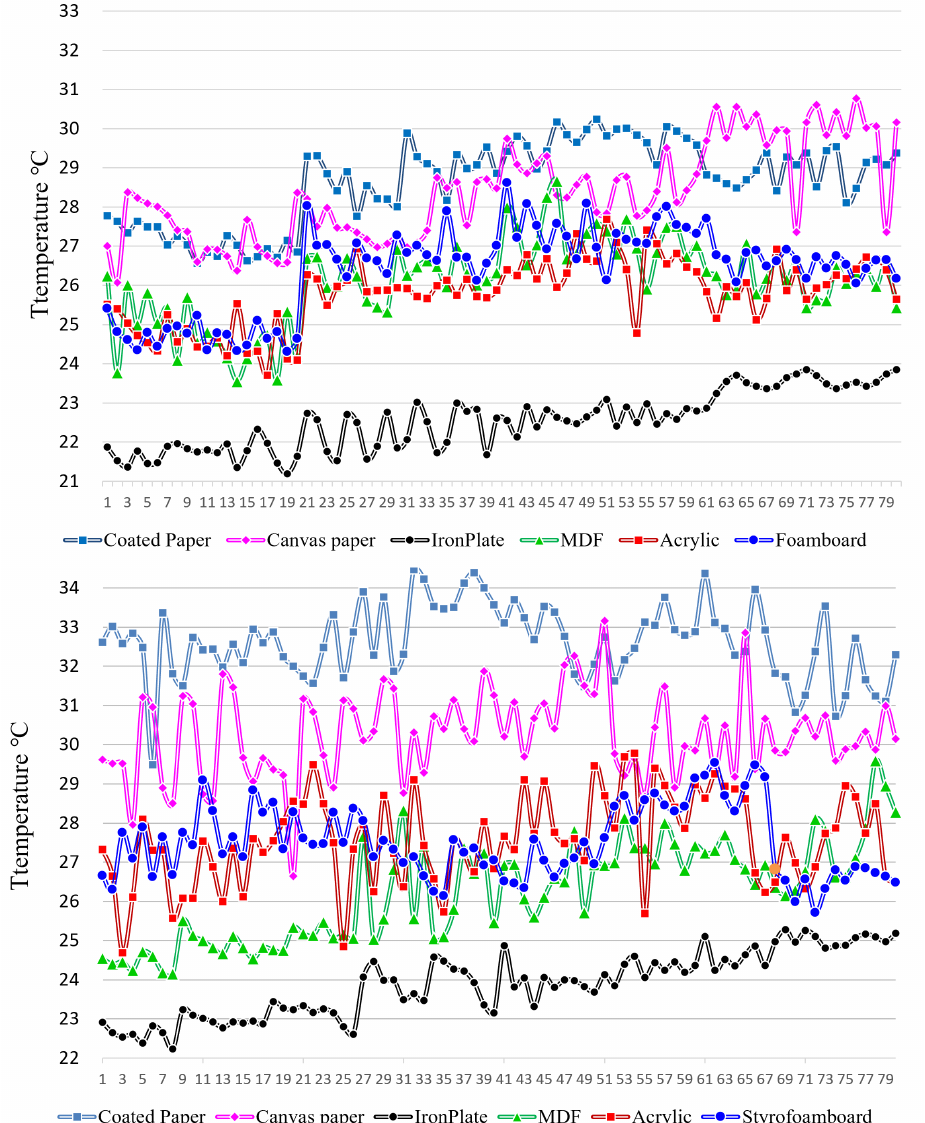
Figure 7. First experiment hot spot temperature graph for each material. Creation method: top : fingertip touch, bottom : exhalation using a hollow rod (vertical axis: celsius temperature, horizontal axis: temper- ature data of